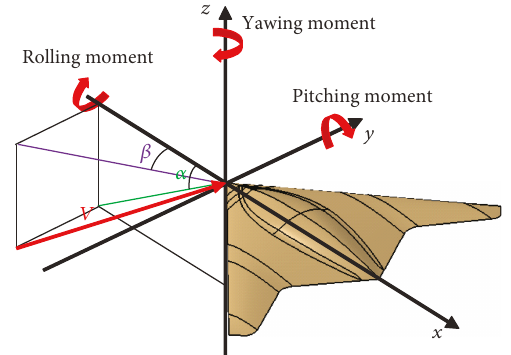
Figure 2: Coordinate system and sign convention of moment.